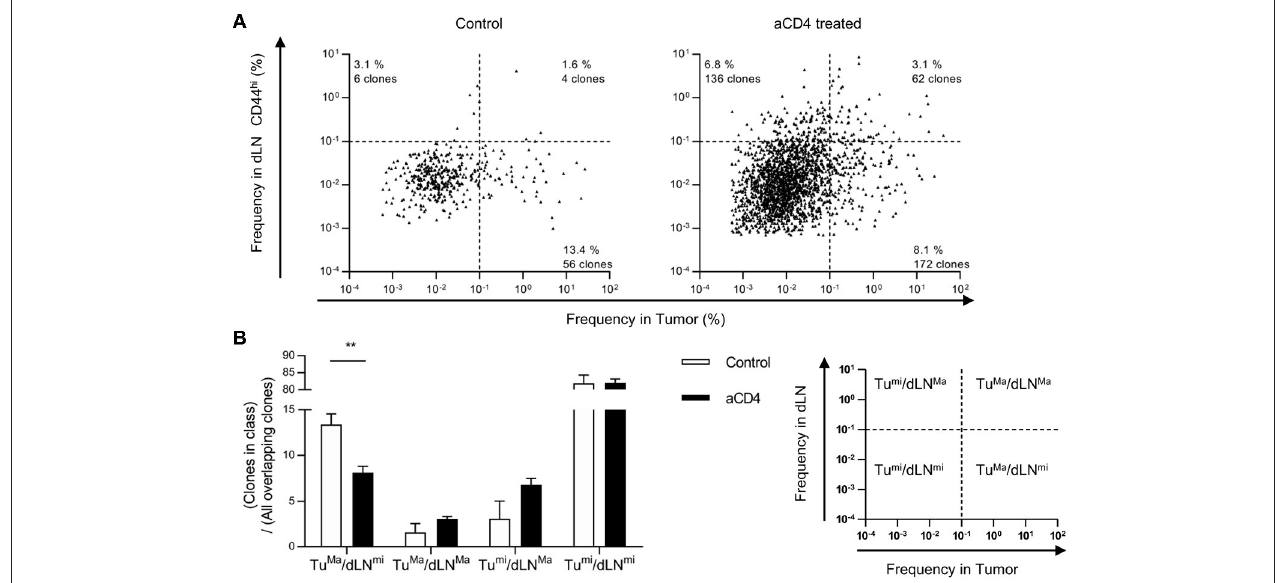
FIGURE 5 | Anti-CD4 mAb treatment increased the proportion of “dLN major ” clones in the dLN-tumor overlap. Mice bearing B16F10 tumors were injected i.p. with anti-CD4 mAb on days 5 and 9, and analyzed on day 14 after tumor inoculation. (A) Scatter Plot of overlapping clones between the tumor and dLN in TCR β repertoire. Each point on the plot represents a single clone with log 10 frequency in the tumor (x-axis) and the dLN CD44 hi (y-axis). The threshold for major/minor clones was defined as a frequency of 0.1% in each compartment. Plots of control ( n = 5, left) or aCD4 ( n = 5, right) mice were overlaid in each group. (B) Percentages of each pattern in overlapping clones. The percentage of each pattern was calculated in individual mice, and averaged in control and aCD4 groups. All figures present the data for TCR β . Two-sided unpaired Student’s t -tests ( n = 5). ** P <